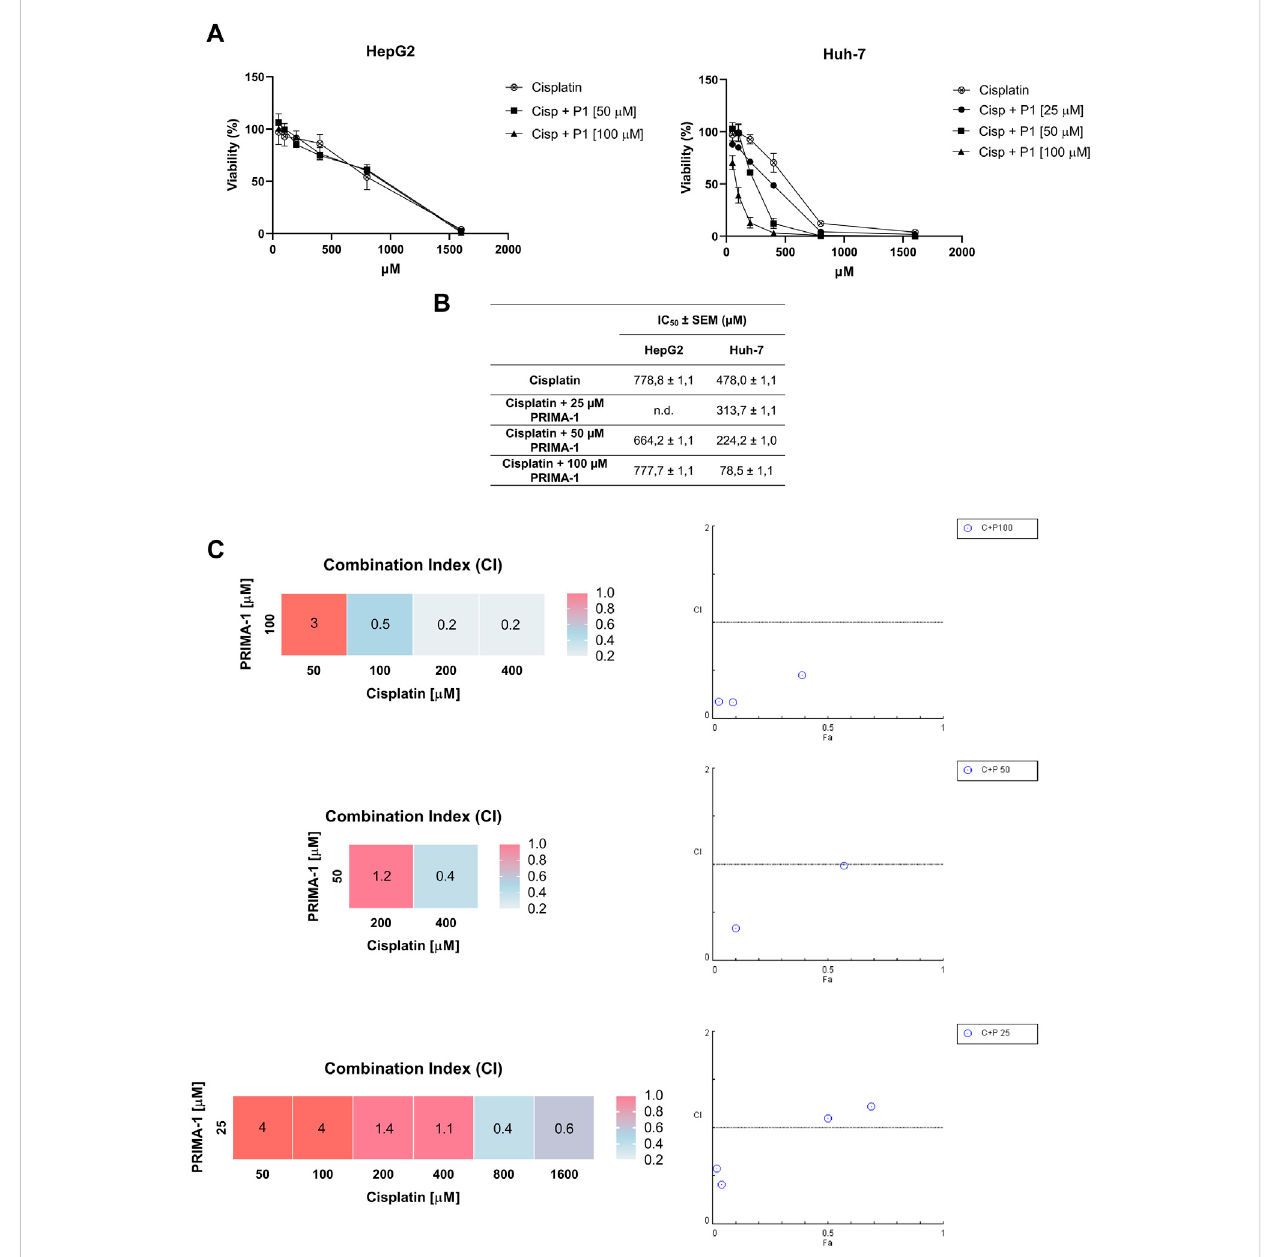
FIGURE 8 Combined PRIMA-1 (P1) and cisplatin (Cisp) chemosensitivity. (A) Cells were treated with different concentrations of cisplatin and PRIMA-1 (25, 50, and100 µM)for24 handanalyzedbyMTTassay. (B) CalculationoftheIC 50 valueswasperformedthroughdose-responsecurves. (C)